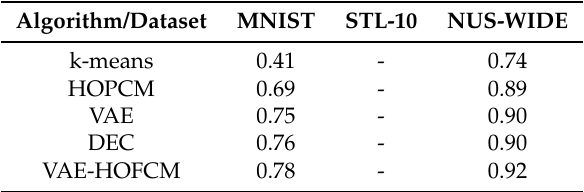
Table 2. Clustering accuracy of